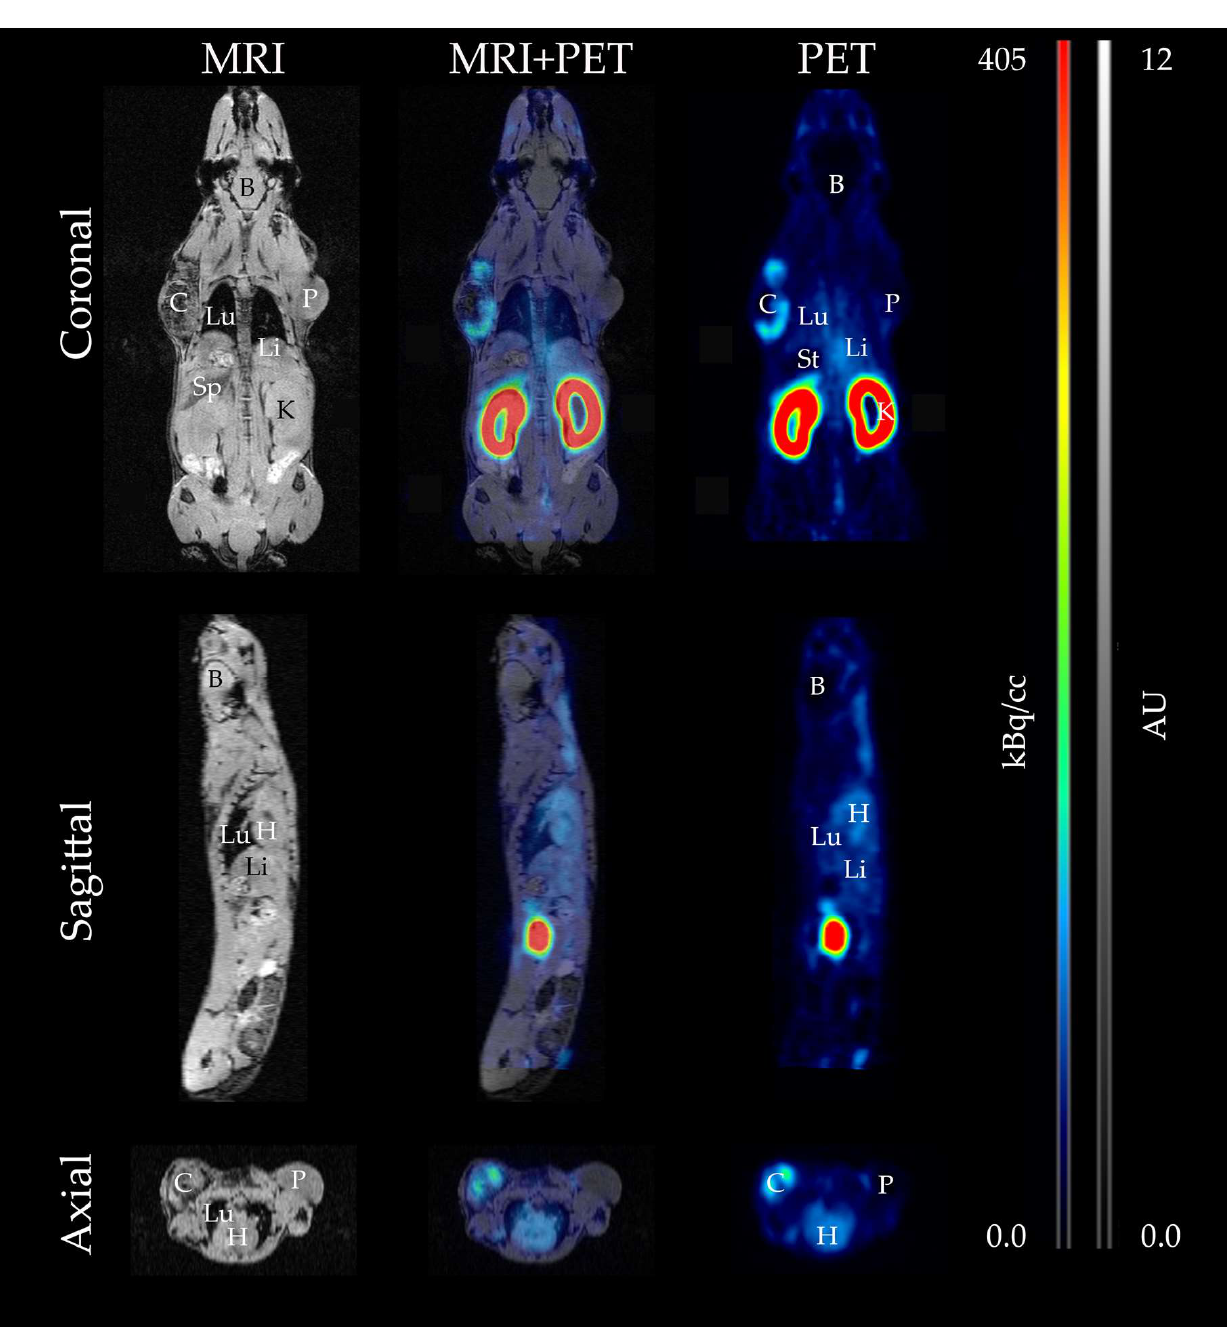
Figure 6. Assessment of [ 18 F]F-siPSMA-14 biodistribution in tumor-bearing mice by MRI and PET. Anatomy is visual- ized by T1-weighted MR images ( left panel ), and the accumulation of [ 18 F]F-siPSMA-14 is represented by PET images ( right panel ). In the corresponding fusion image ( middle column ), the radioactive signal can be assigned to the respective organs. In the 3 section planes (coronal, sagittal, and axial), radioactive signal is assigned in PSMA + LNCaP C4-2 tumor (C), whereas no accumulation higher than the background signal can be seen in PSMA - PC-3 tumor (P). Also, no accumulation of [ 18 F]F-siPSMA-14 is detected in brain (B) and stomach (St). Increased activity is observed in heart (H), liver (Li), lung (Lu), and spleen (Sp), whereas the highest activity is detected in the kidneys (K). Time-activity curves for the selected organs: brain, heart, liver, and kidneys, based on the MRI and PET fusion images, are depicted in Figure